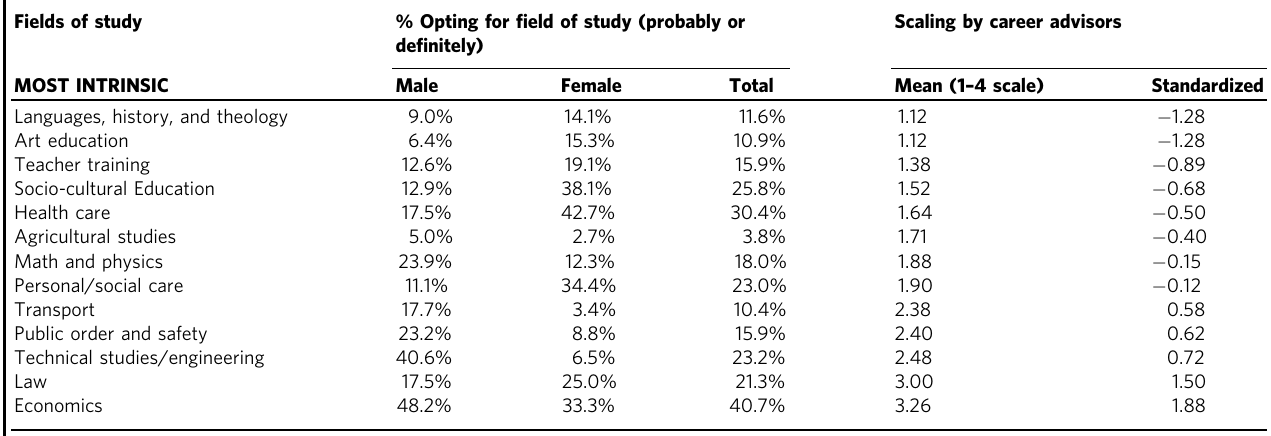
Scaling by career advisors